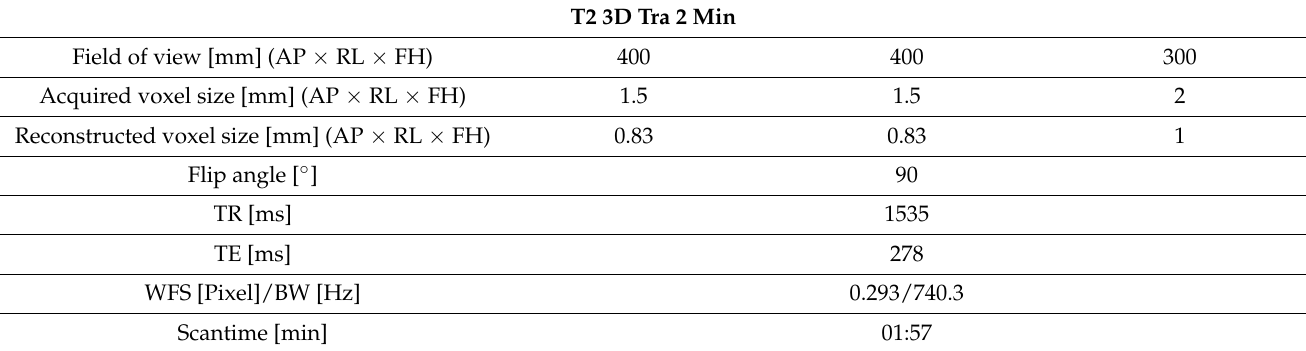
Table 1. MRI sequence parameters used for daily plan adaption.